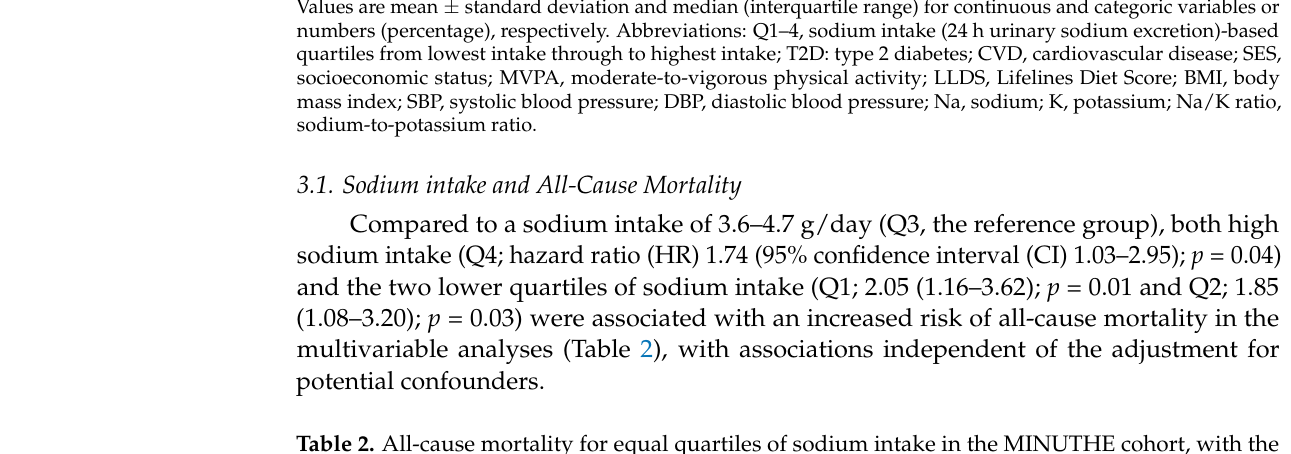
Table 2. All-cause mortality for equal quartiles of sodium intake in the MINUTHE cohort, with the third quartile as the reference